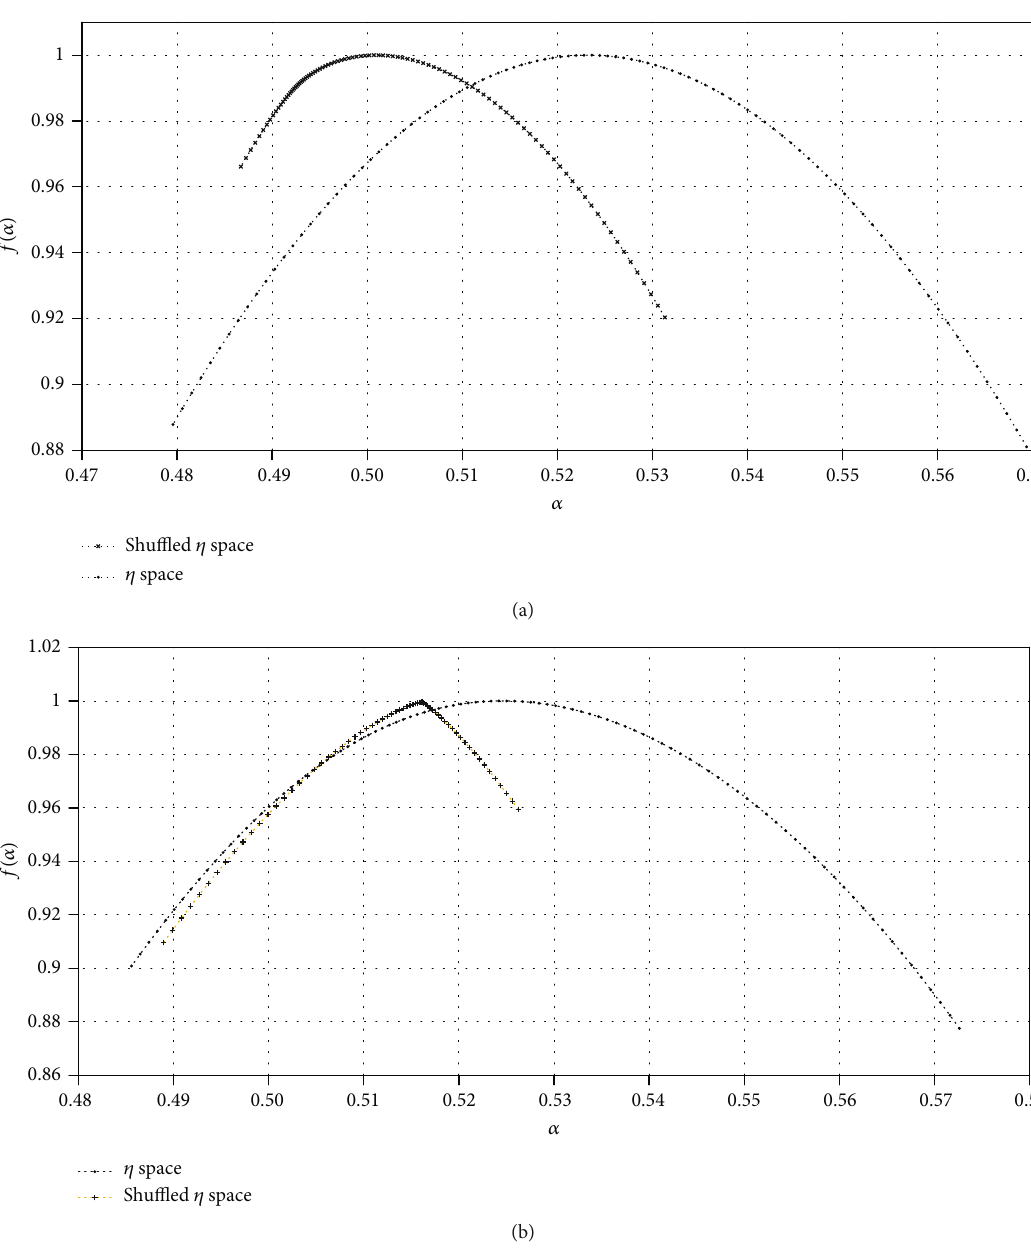
Figure 2: Comparison of the trend of di ff erent values of f ð α Þ versus α between the original and the randomized version of the η space for a particular range of η values for (a) 8TeV dataset and (b) 7 TeV